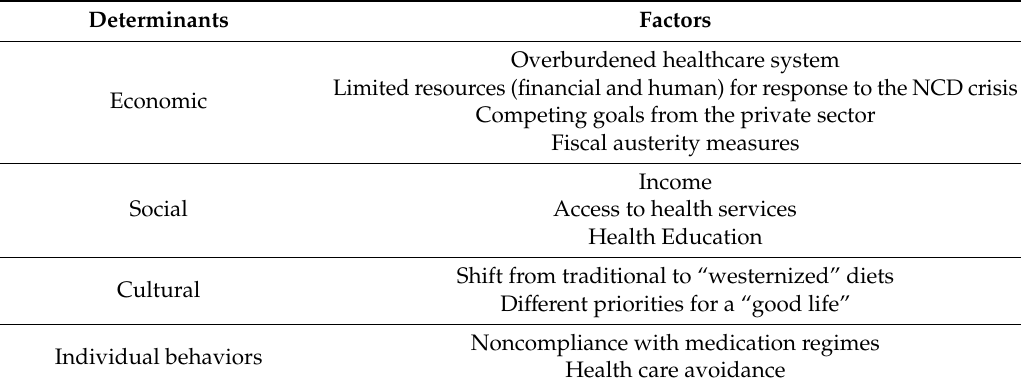
Table 3. Factors hindering the reduction in the burden of healthcare in